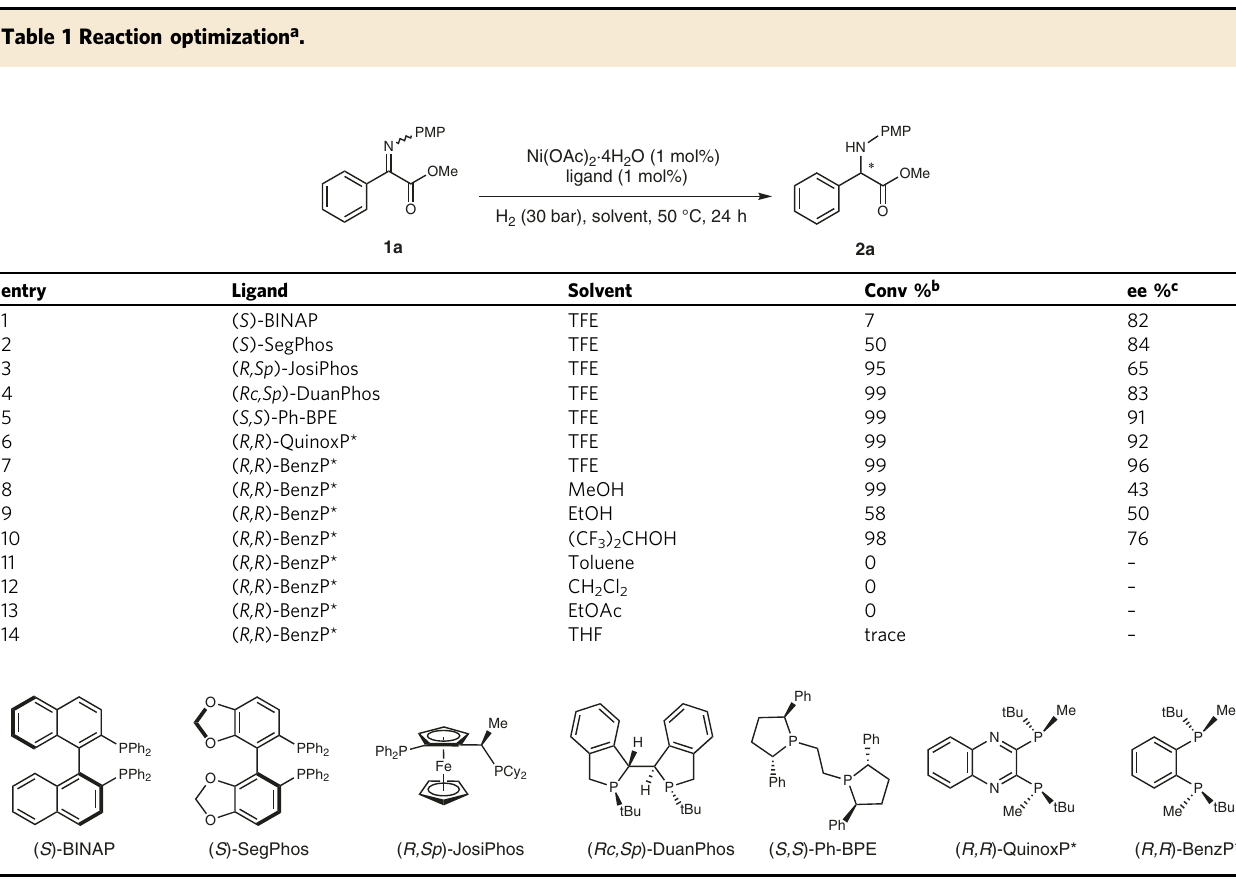
Table 1 Reaction optimization a